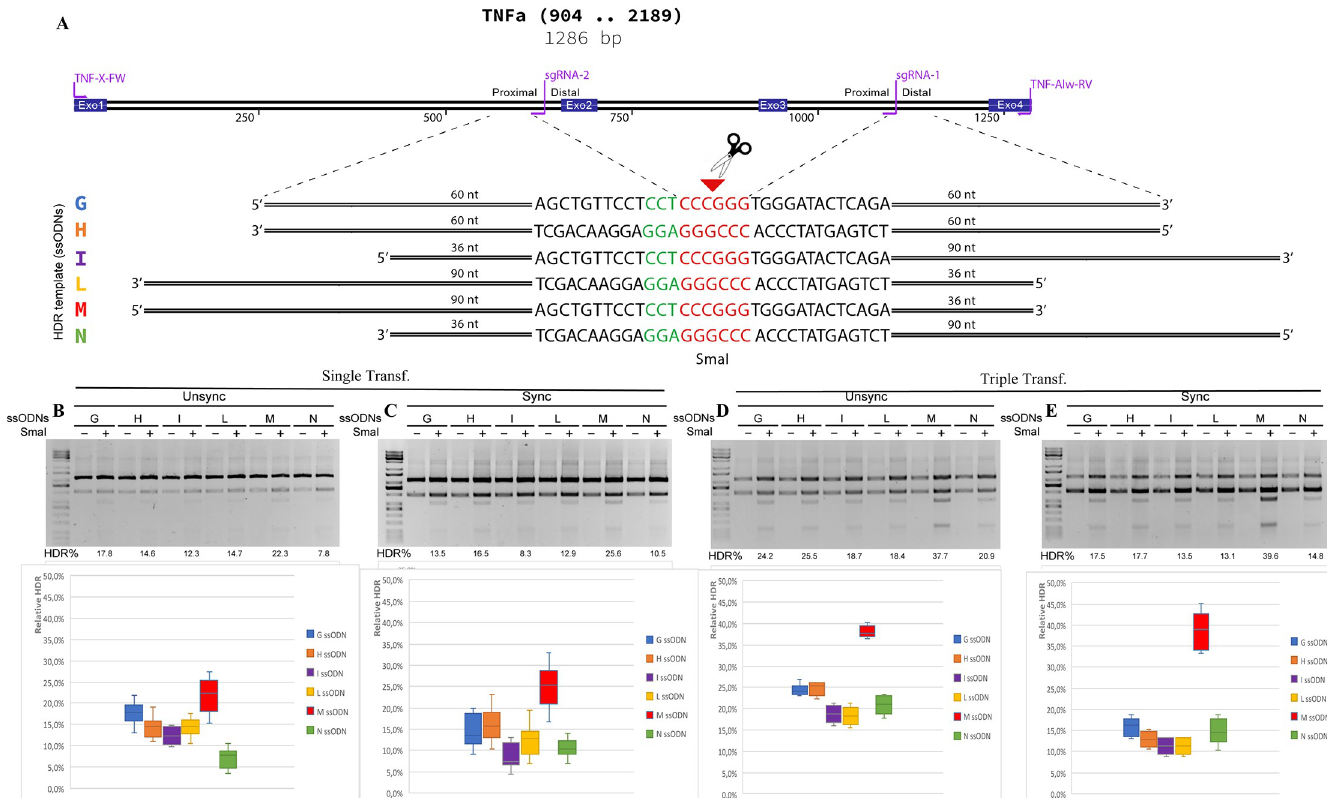
Fig 5. Systematic investigation of DNA templates, and two sgRNA, for efficient HDR at the TNF α locus in HEK293 cells. ( A ) A segment of human TNF α shows the genome structure, the two sgRNA 2 guides (sgRNA1, sgRNA2) sites, and the primer used for PCR amplification (in violet). +1: ATG Six HDR templates (color-coded) were tested for HDR efficiency, the PAM region (in green). Template ssODNs contains SmaI restriction sites (in red) that are flanked by various lengths of homology arms. ( B ) HDR efficiency was tested in single and triple transfection, in combination with synchronized cells. The mean % HDR and standard deviation (error bar) were determined by SmaI digestion from eight and nine replicates. Representative gels from PCR and HDR analyses are shown for each cell condition.